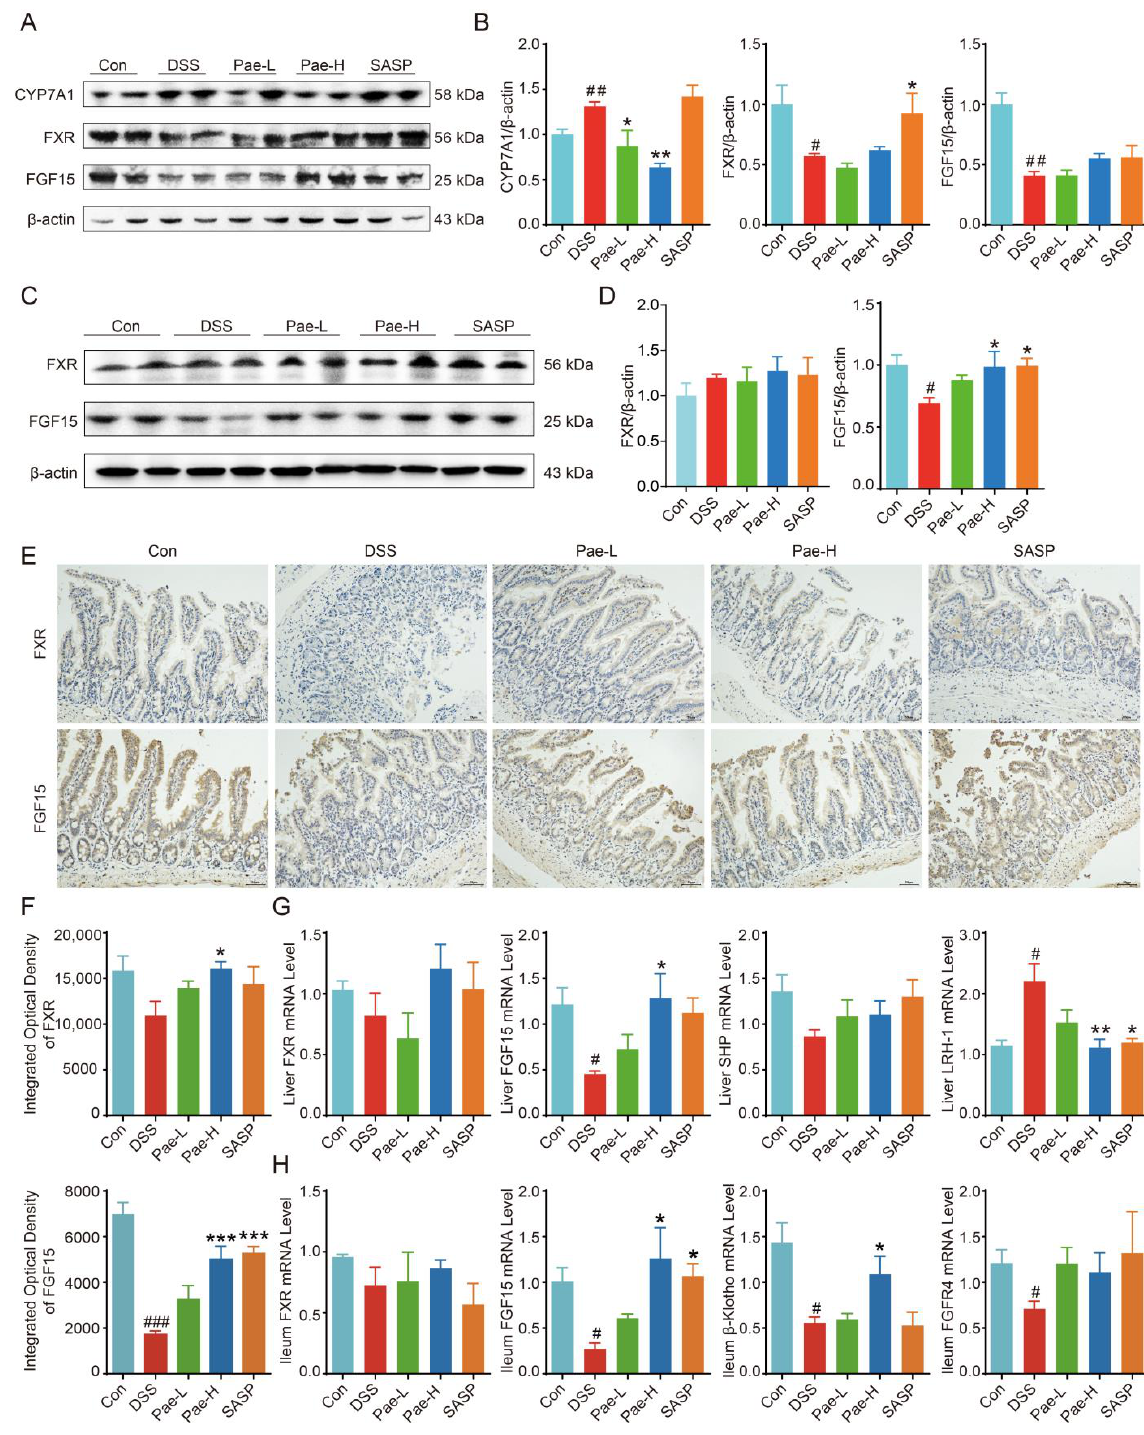
Figure 6. Pae improves UC via pathways involving gut microbiota-BAs-FXR/FGF15 signaling. ( A , B ) Representative immunoblots and the relative expression levels of CYP7A1, FXR and FGF15 proteins in liver tissues from different treatment groups. ( C , D ) Representative immunoblots and the relative expression levels of FXR and FGF15 proteins in ileum tissues from different treatment groups. ( E , F ) Immunohistochemistry staining and quantitative analysis of FXR and FGF15 protein content in the distal ileum (scale bar, 50 mm). ( G ) The mRNA levels of FXR, FGF15, SHP and LRH-1 for each group in the liver. ( H ) The mRNA levels of FXR, FGF15, β -Klotho and FGFR4 for each group in the ileum. Data are presented as the mean ± sem. n =3 or 4. # p < 0.5; ## p < 0.01; ### p < 0.001, compared with Con group, * p < 0.5; ** p < 0.01; *** p < 0.001, compared with DSS